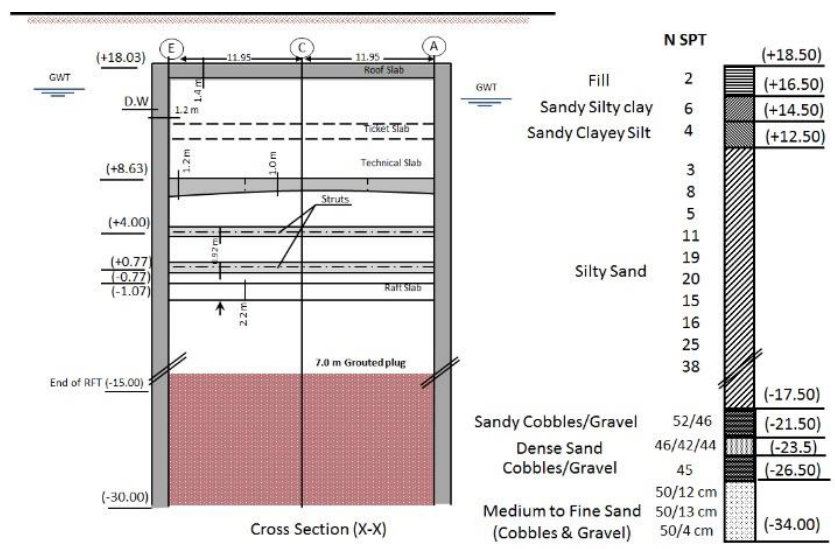
Figure 4. Soil profile at the location of BH No. 46-B. [30].